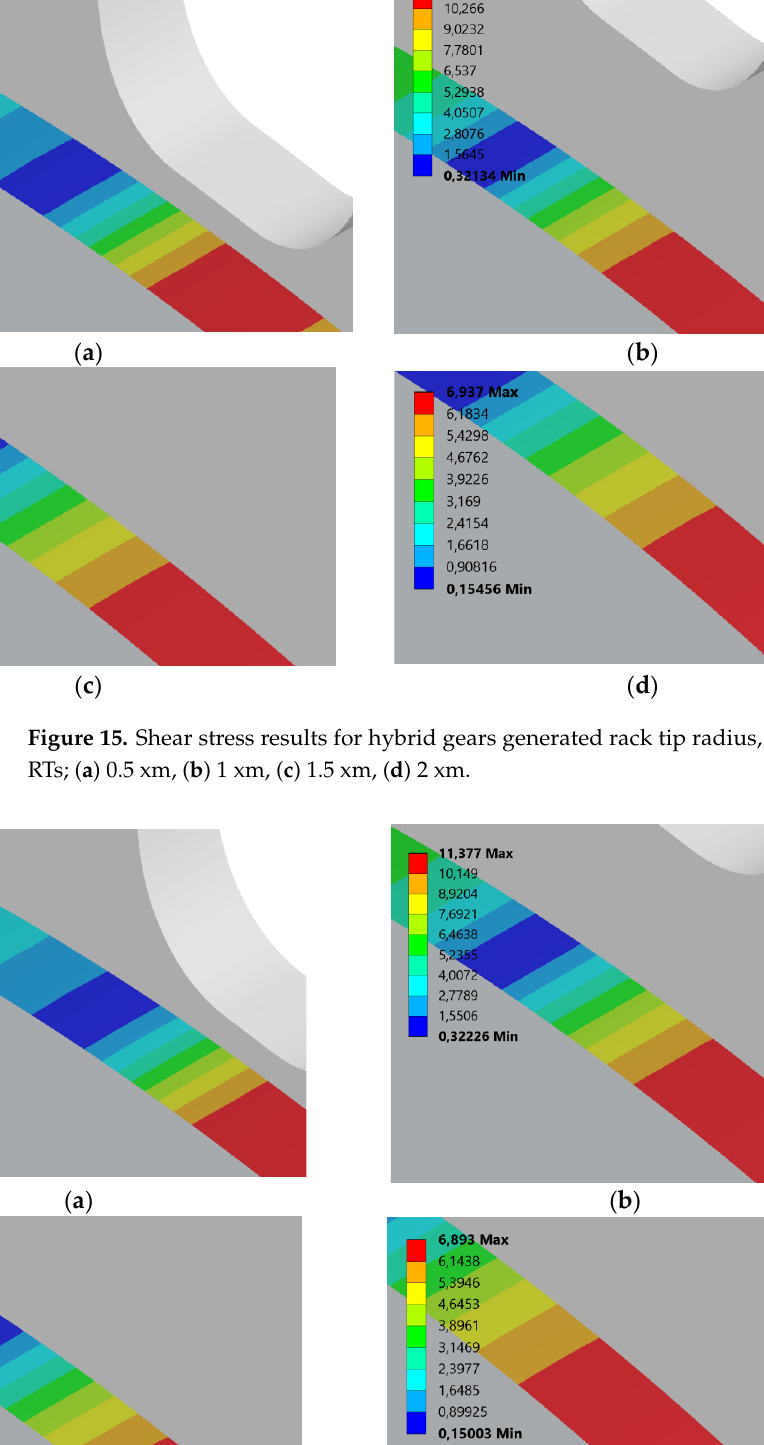
Figure 14. Shear stress results for hybrid gears generated rack tip radius, ρ 1 = 0.1 xm for different